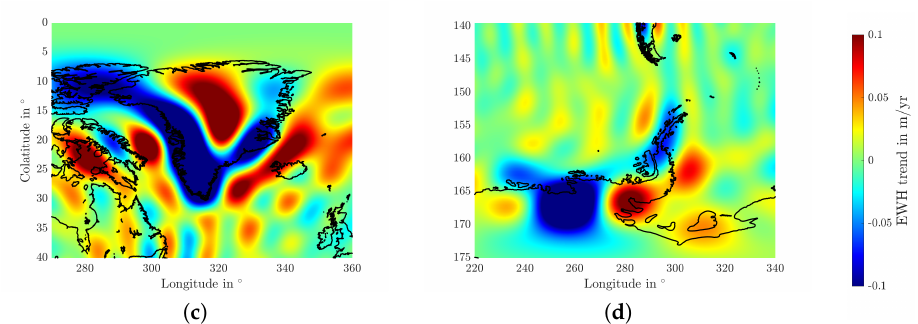
Figure 12. EWH trend grids derived from 20 bi-monthly SH d/o 60 gravity field models for the four-year GOCE data period. Panels ( a , b ) show the results based on GOCE SGG-only models, and panels ( c , d ) show the results based on GRACE-only models [8], respectively. To eliminate the long-wavelength noise in the GOCE models, only non-polar gap wedge coefficients of degrees 10 to 60 have been used in all shown panels.